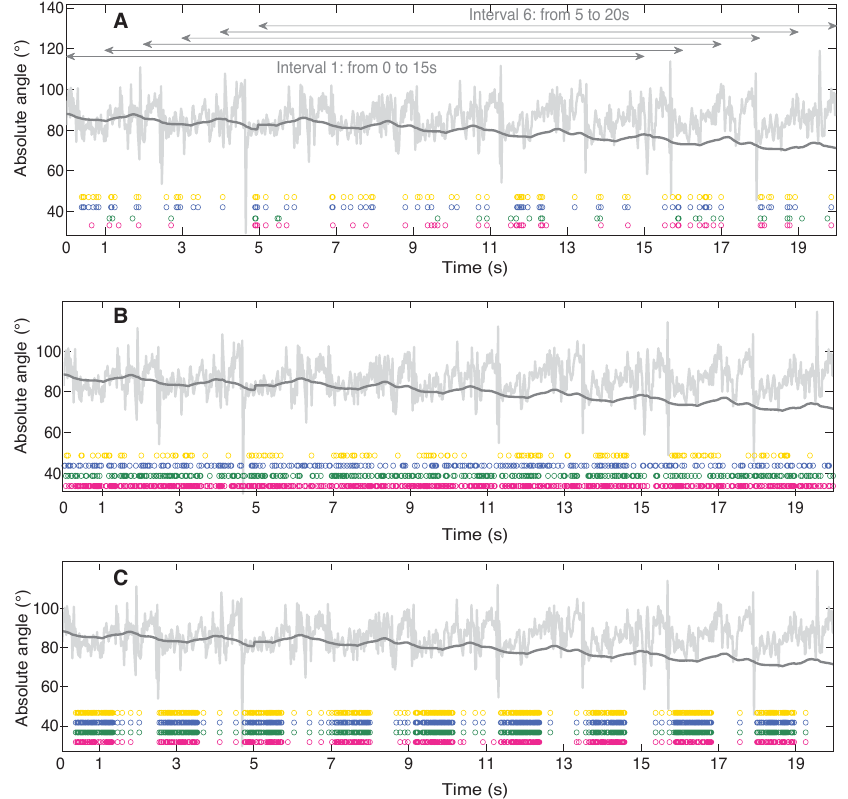
Figure 4. Performance of the Local KF (panel A ), Markovian KF (panel B ), and Matricial KF (panel C ). The calibrations are color coded with pink (cal. 1) and green (cal. 2) referring to the simplified calibrations; and purple (cal. 3) and yellow (cal. 4) referring to the complex calibrations. The light grey curve displays the accelerometer based estimate of the absolute angle. The gyroscope based absolute angle estimate is shown in dark grey. Each dot stands for an update in which the accelerometers are used by the Kalman Filter. The horizontal lines in panel A indicate the six different KF initialization points and their respective